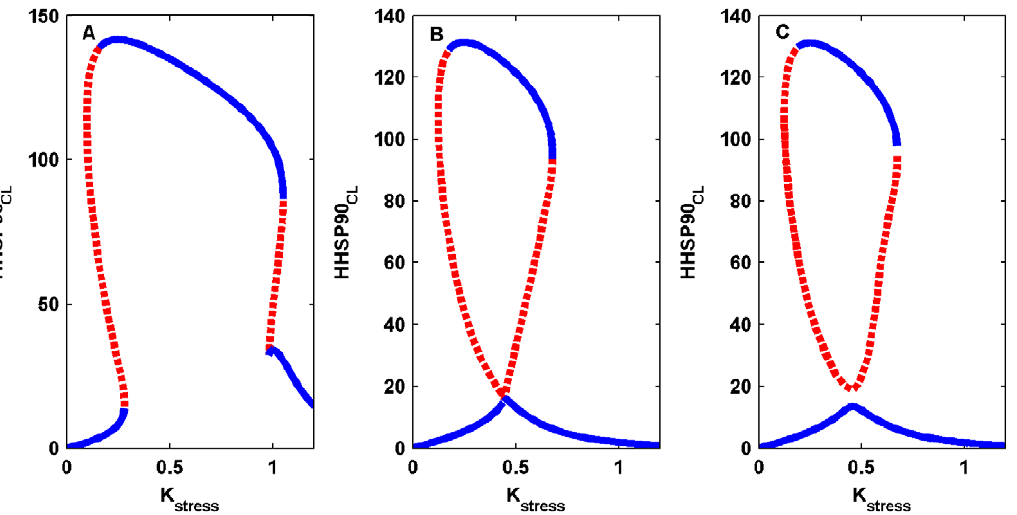
Figure 11. Transition from mushroom dynamics to an isola due to the variation in the phosphorylation-dephosphorylation (PdP) kinetic parameter. (A) Slowing down of the phosphorylation reaction is modulated by varying the kinetic constant k 7 from 0.08 to 0.038, which results in the S-shaped, and Z-shaped forms coming closer to each other. (B) Further decrease of k 7 (0.0383) results in the mushroom touching the lower steady state and the lower limit points of S-shaped and Z-shaped forms of bistablity are merged together. (C) Isolated stable steady state along with unstable steady state is formed when the mushroom is pinched off from the lower stable steady state ( k 7 ~ 0 : 038 ). This is termed an ‘‘Isola’’. The blue color denotes the stable steady state, whereas the unstable steady state is denoted by the red dotted lines.